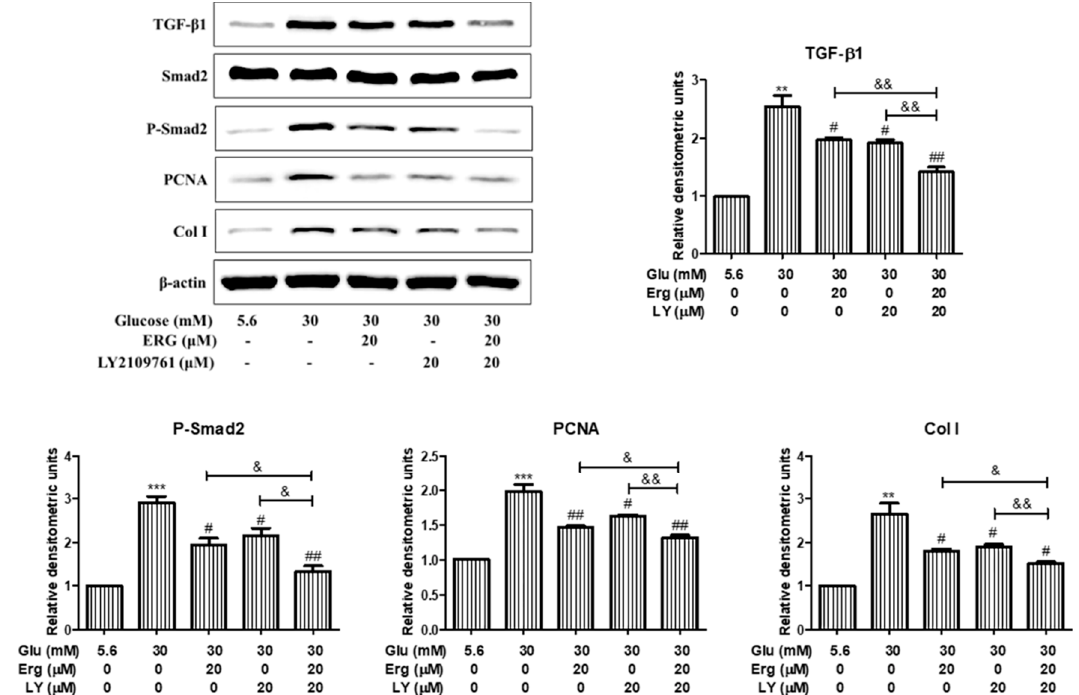
Figure 8. TGF- β 1/Smad2 signaling was involved in the effects of ergosterol on high glucose-exposed RMCs. This figure shows the expression levels of TGF- β 1, Smad2, phosphor-Smad2, PCNA, and collagen I in RMCs cultured under different conditions through Western blotting. Glu: glucose; Erg: ergosterol; LY: LY2109761, inhibitor of Smad2. Data are presented as the means ± SD, performed in triplicate. ** p < 0.01, *** p < 0.001 compared with the normal glucose; # p < 0.05, ## p < 0.01 compared with the high glucose; & p < 0.05, && p < 0.01 compared with the treatment of LY2109761 plus ergosterol.